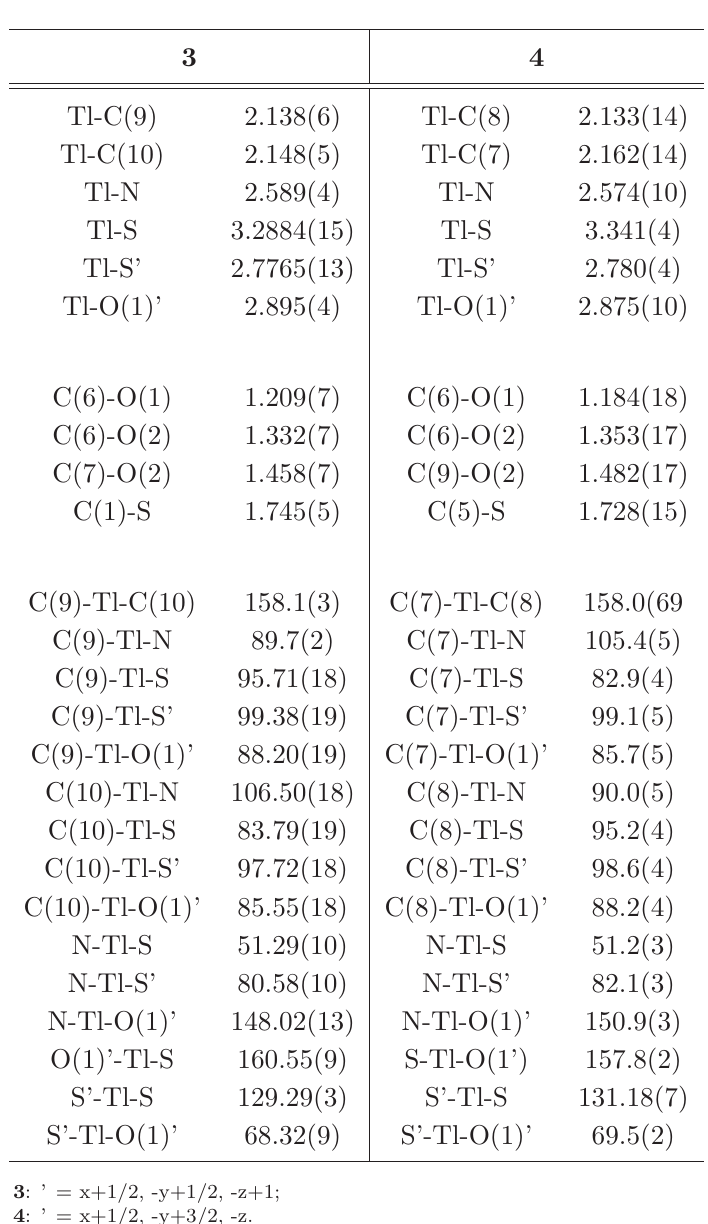
Table 6 Selected bond lengths ( ˚ A) and angles (deg.) for compounds 3 and 4